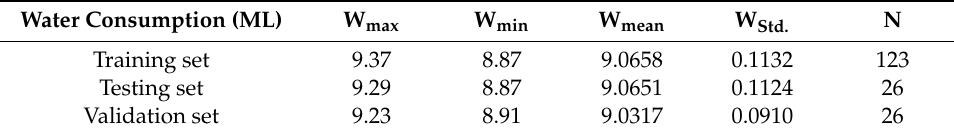
Table 1. The statistical parameters for training, testing, and validation sets.